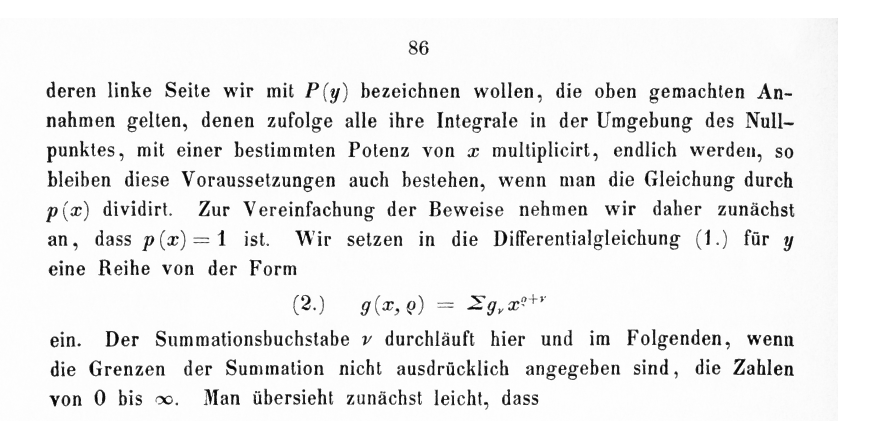
Figure 2. Frobenius’ Ansatz , our Equation (5), as published in 1873 [6], at the top of the third page of his paper. This fragment also contains the choice to normalize the coefficient of the highest order derivative, i.e., to set “ p ( x ) = 1”, Zur Vereinfachung der Beweise (“To simplify the